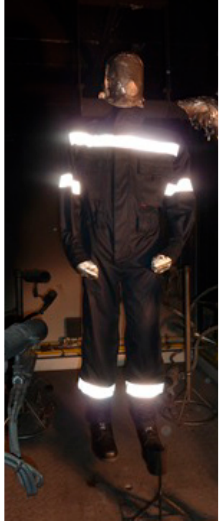
Figure 2. Tested overalls on the fire manikin.